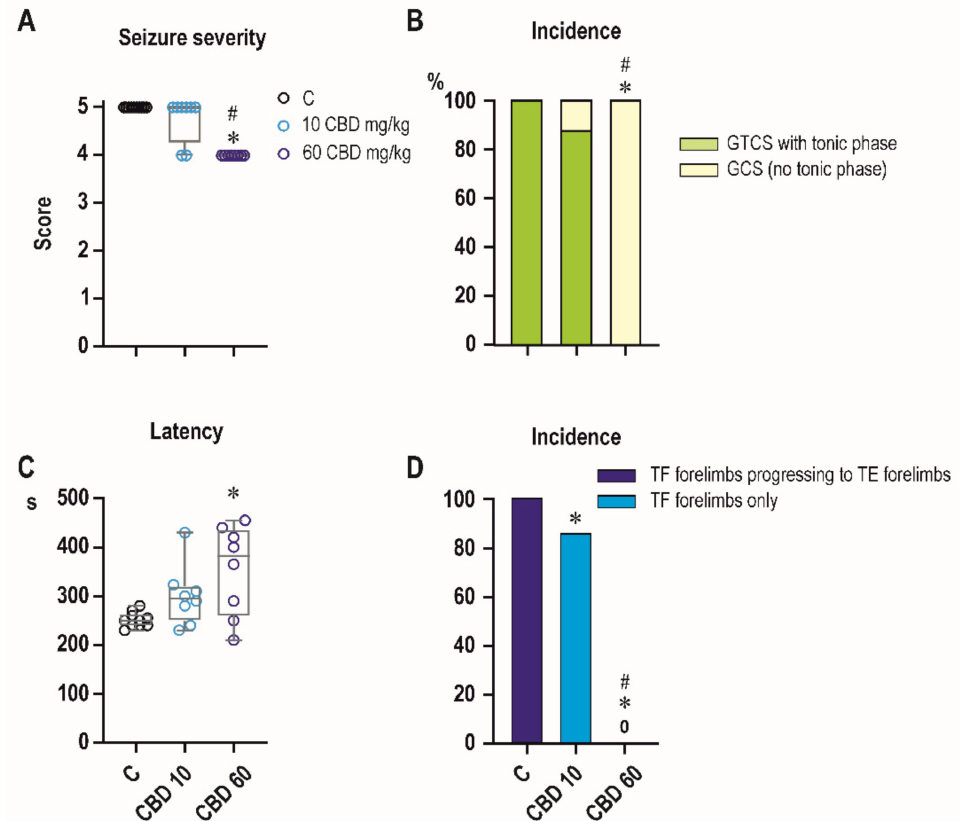
Figure 2. Effects of CBD in PTZ model. Effects of CBD in two doses (10 and 60 mg/kg) on PTZ- induced seizures. CBD in a dose of 60 mg/kg significantly decreased seizure severity ( A ) and this effect was driven mostly by specific suppression of tonic component of generalized tonic-clonic seizures ( B ). The percentage of animals exhibiting complete generalized tonic-clonic seizures (green) and generalized seizures without tonic phase, i.e., generalized clonic seizures (yellow) is on axis y. In this dose, CBD resulted in increase of latency to generalized seizures ( C ). In lower dose of 10 mg/kg, CBD blocked transition from tonic flexion (pale blue; TF forelimbs only) to tonic extension on forelimbs (dark blue; TF forelimbs progressing to TE forelimbs) ( D ). Asterisks denote a significant difference in comparison with controls, # denote a significant difference in comparison between different doses of CBD. x axis in all three graphs presents control and two groups with different doses (10 and 60 mg/kg) of CBD. Data in graphs ( A , C ) are presented as box plots (the sample median and the first and third quartiles) with whiskers (min and max). Circles mark individual